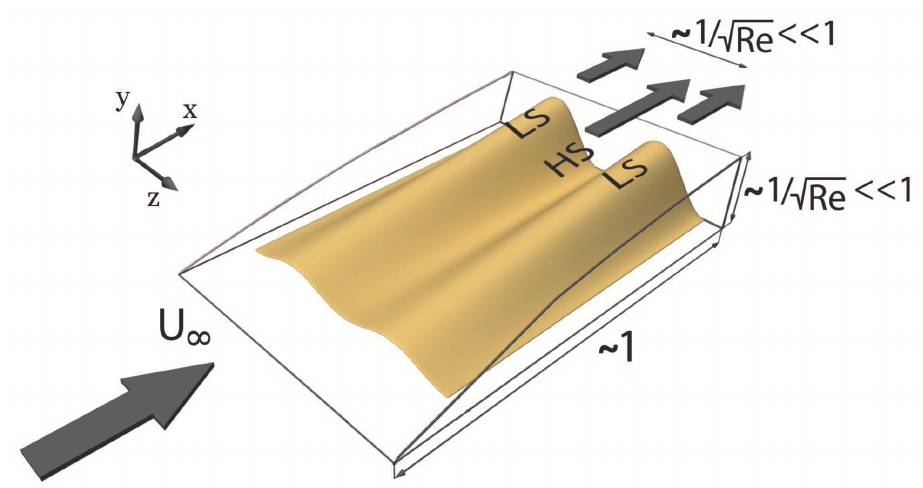
Figure 1. Sketch of a flat plate boundary layer with a spanwise periodic array of steady streaks developed. The asymptotic scaling for Re (cid:29) 1 is shown. LS (HS) stands for low (high) velocity in the streamwise